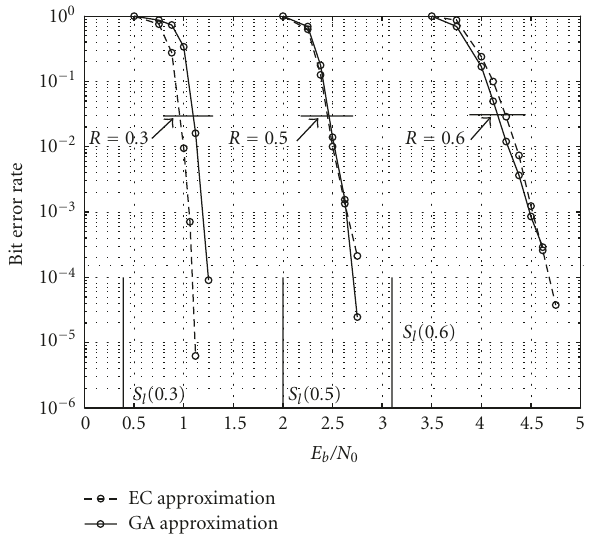
Figure 3: Simulation results for the optimized LDPC codes given in Tables 1 and 2. The codeword length is N = 50000. The maxi- mum number of iterations is set to 200. For comparison, we have indicated the Shannon limit for the three considered